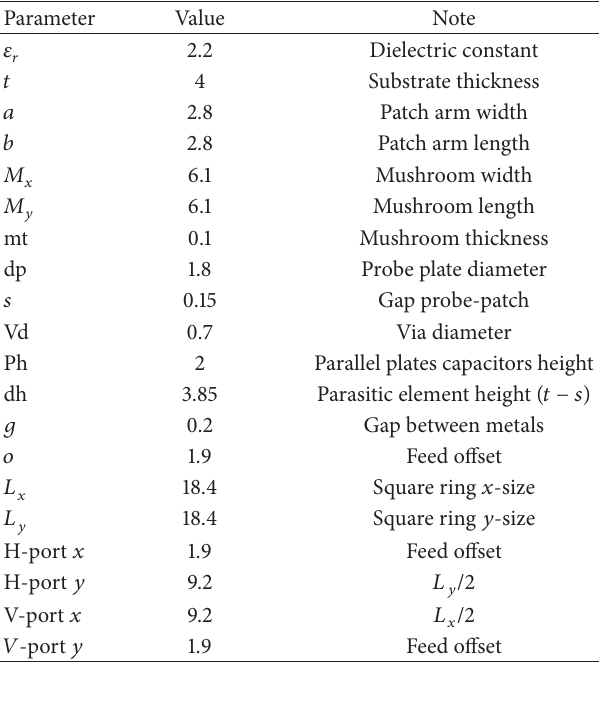
Table 3: Single element physical parameters.